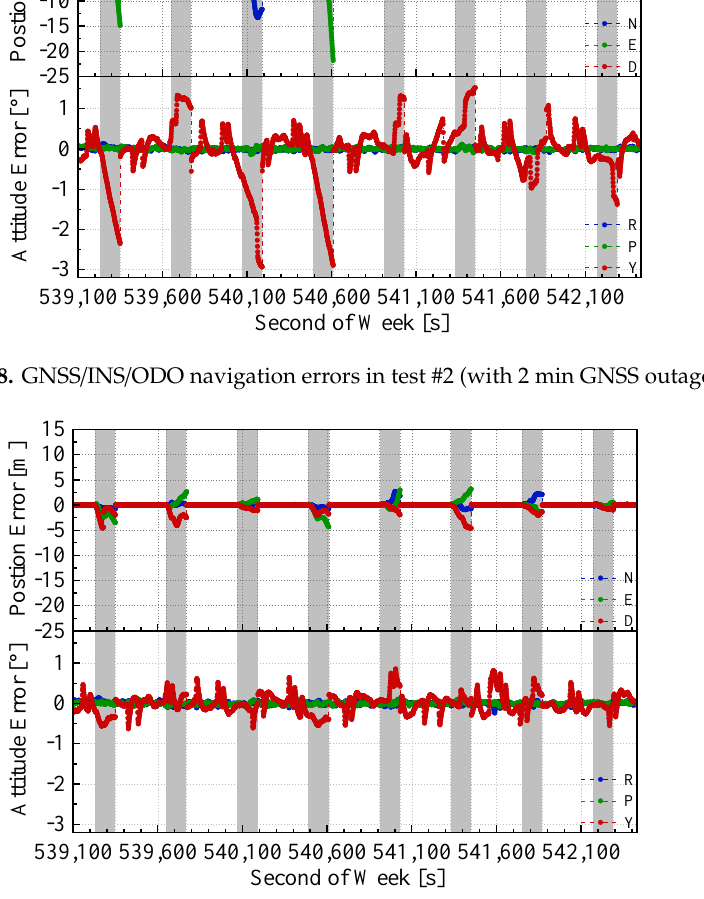
Figure 9. GNSS/IMU/LiDAR-SLAM navigation errors in the test #2 (with 2 min GNSS outages)